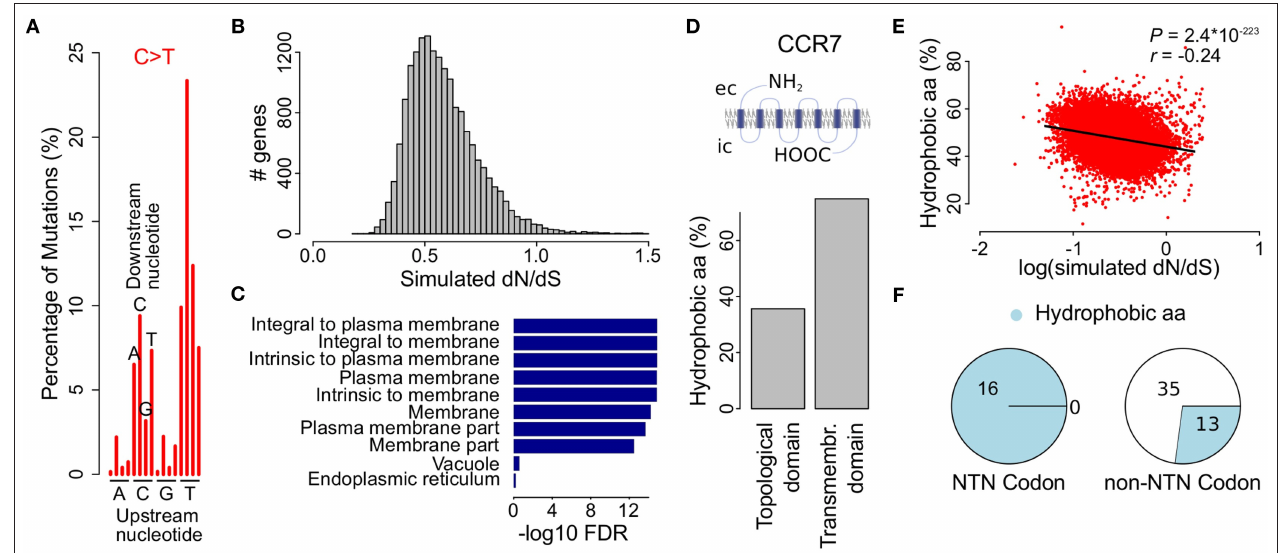
FIGURE 3 | Simulations using the melanoma 96-class signature show decreased dN/dS values in genes coding for membrane proteins. (A) Bars indicate different proportions of up- and downstream nucleotides for C > T substitutions in malignant melanoma. See Figure S2 for the complete 96-class mutational signature. (B) Simulation of the effect of the malignant melanoma 96-class mutational signature on the observed dN/dS values. (C) GO cellular component gene set enrichment analysis for genes with the lowest simulated dN/dS values (i.e., below 0.35). Cellular components are ranked on significance (bars) and only the 10 most significantly enriched components are shown. (D) Membrane proteins are composed of transmembrane and topological domains. This structure is exemplified by CCR7 , a gene that codes for a G-protein coupled receptor and was found to have low simulated dN/dS values. Bar plot compares the proportion of hydrophobic amino acids between the topological and the transmembrane domain. ec, extracellular; ic, intracellular. (E) Scatter plot shows the percentage of hydrophobic amino acids as a function of the simulated dN/dS value (log scale). Pearson correlation P- and r -values are indicated on top. (F) Pie charts show the distribution of hydrophobic amino acids in codons with or without a thymine on the second nucleotide